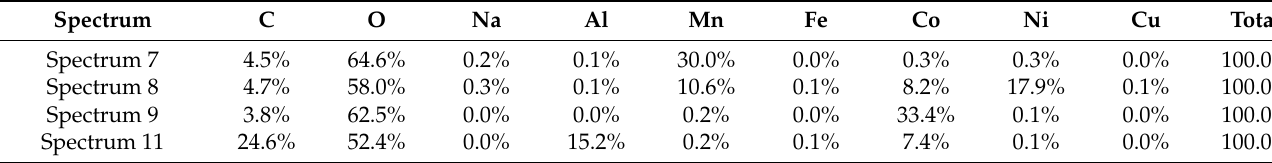
Table A2. Metal molar fractions of identified